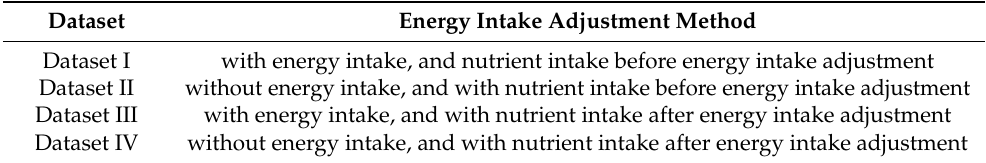
Table 4. Four datasets according to the energy intake adjustment